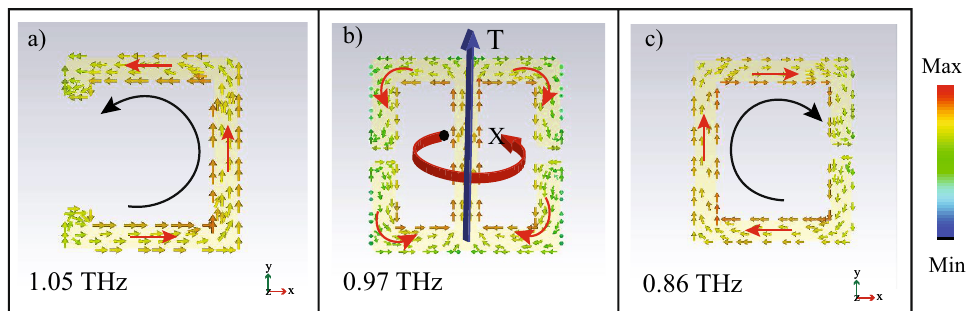
Figure 3. ( a ) Anticlockwise flow of surface current on the left CSRR (1.05 THz) exhibiting electric dipolar excitation. ( b ) Surface current profile in the mid TSRR (0.97 THz) showing end to end formation of magnetic dipole moment leading to toroidal dipolar excitation T. ( c ) Clockwise flow of current in thr right CSRR (0.86 THz) exhibiting electric nature of exciation. Here the green arrow indicates polarization direction of the incident terahertz